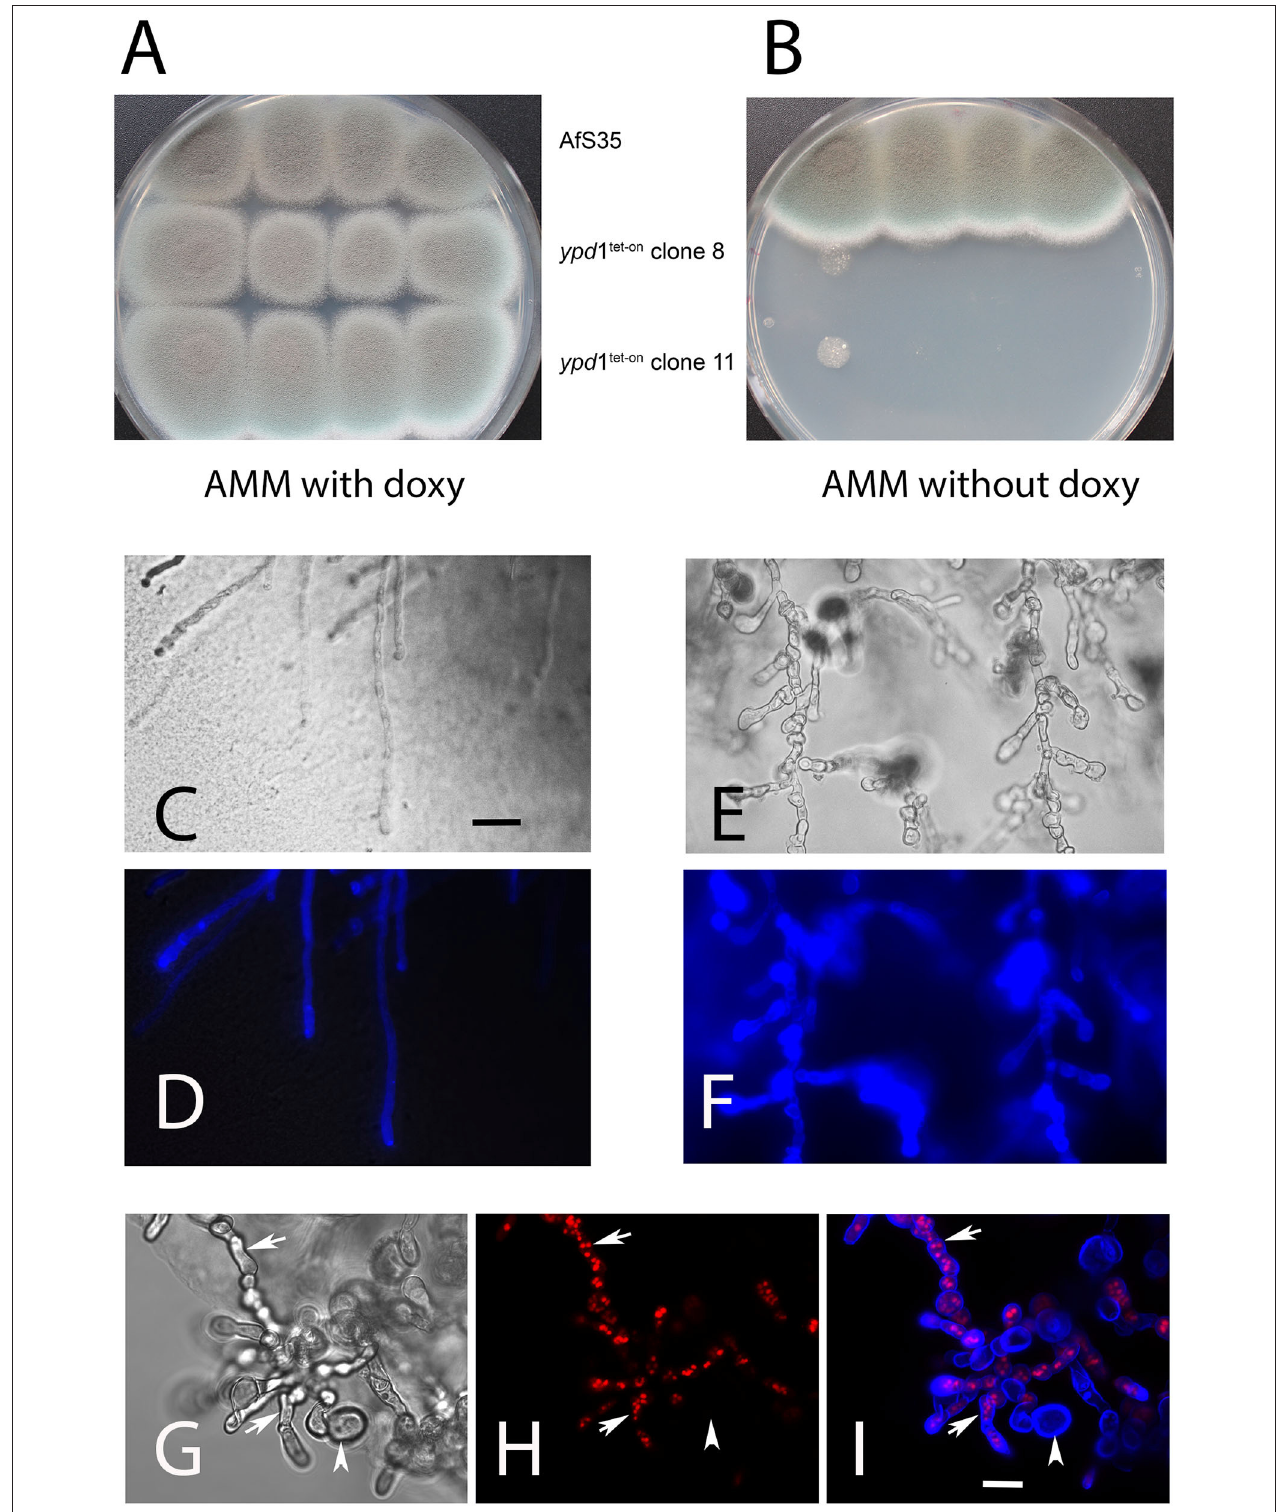
FIGURE 2 | Depletion of Ypd1 is lethal for A. fumigatus . We have analyzed the growth of two clones, in which the ypd 1 gene was cloned under the control of a tet-on promoter construct (AfS35 ypd 1 tet − on ) and the parental strain AfS35 on AMM plates with and without doxycyclin ( A , B , respectively). Under